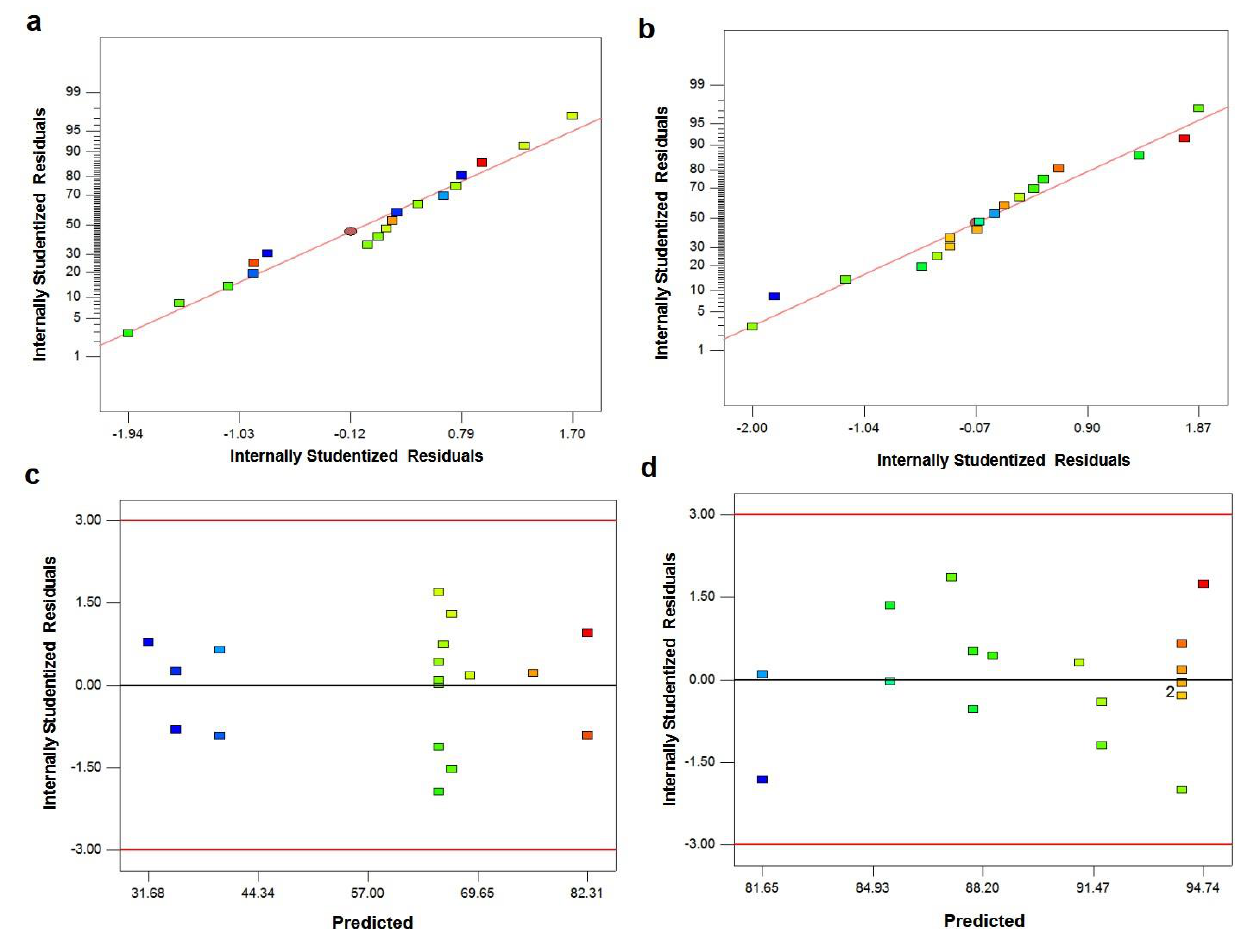
Figure 4. The normal probability plot associated with residuals and the plot associated with residuals vs. predicted response: ( a , c ) UCS and ( b , d ) cell viability.